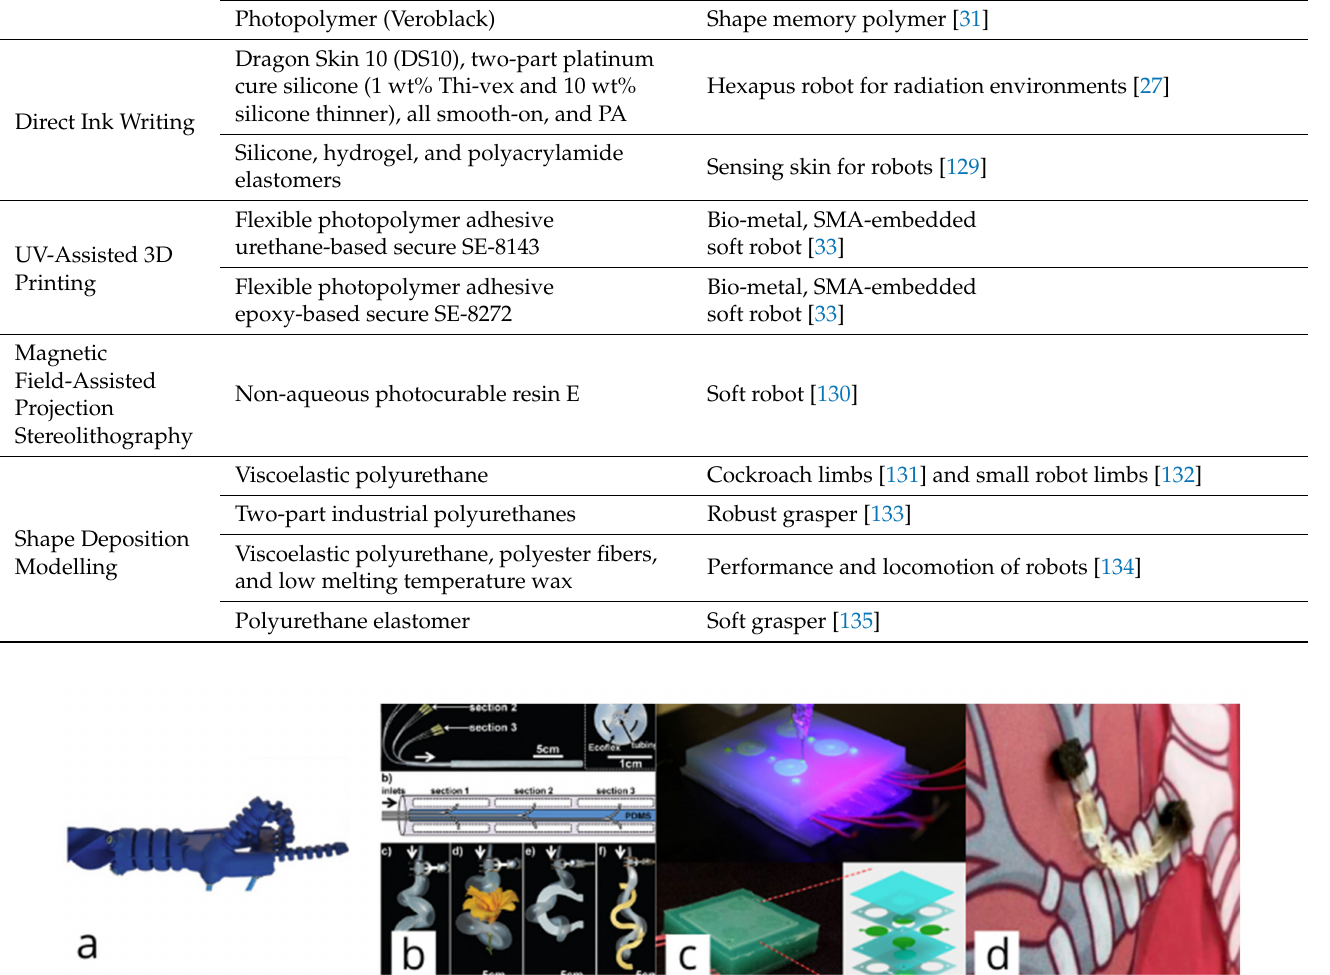
Figure 5. ( a ) Robotic hand made of elastic silicone [114]. Reprinted with permission from ref. [114]. Copyright 2021 Elsevier. ( b ) Polyjet-printed robotic tentacles made of polyethylene glycol [121]. Reprinted with permission from ref. [121]. Copyright 2021 John Wiley & Sons. ( c ) DIW-printed robotic skin embedded with sensors [129]. Reprinted with permission from ref. [129]. Copyright 2021 Elsevier. ( d ) MAG-printed soft robot, also made of Spot E [130]. Reprinted with permission from ref. [130]. Copyright 2021